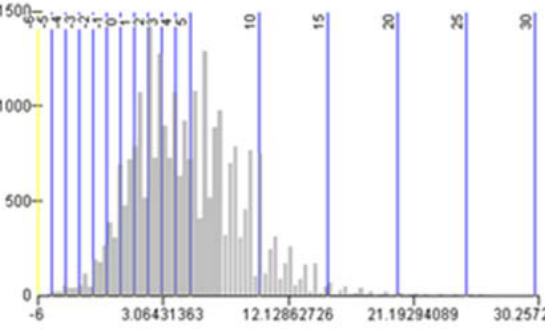
Figure 4c. Histogram of differences between ASTER v2 and OSGB terrain models, Wicken Fen